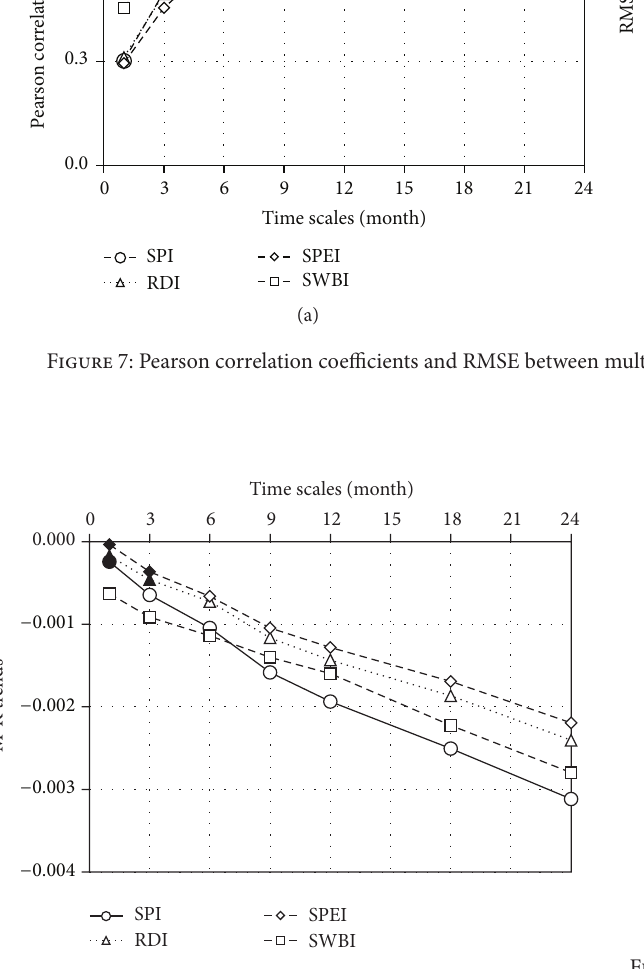
Figure 8: Mann-Kendell trends of drought indices: solid dots represent the decreasing trends which are insignificant, while open dots indicate the decreasing trends which are significant at 𝑃 = 0.05 .